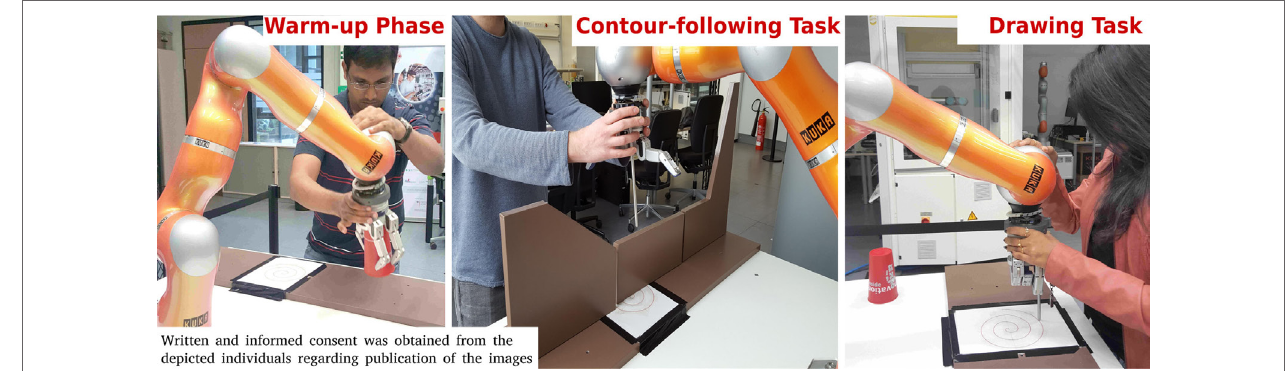
FigUre 1 | The robotic system: study participants interacting with the robot and performing the tasks.